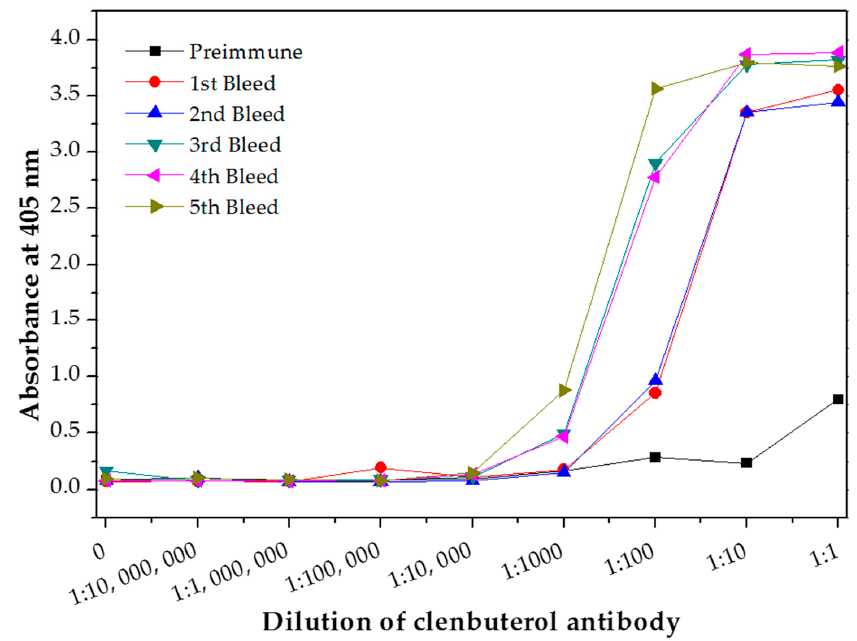
Figure 3. Antibody titer of the purified polyclonal anti-CLB antibody.